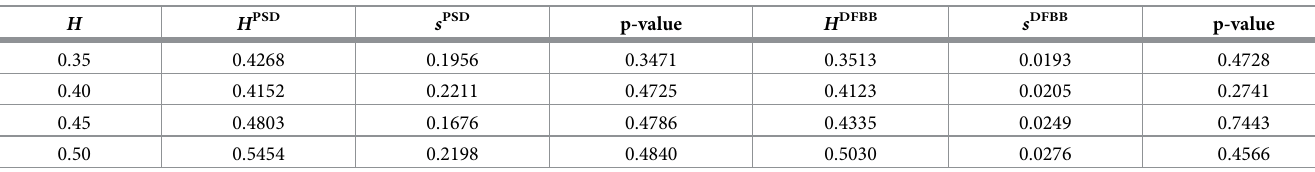
Table 8. Unbiasedness of PSD and DFBB methods as